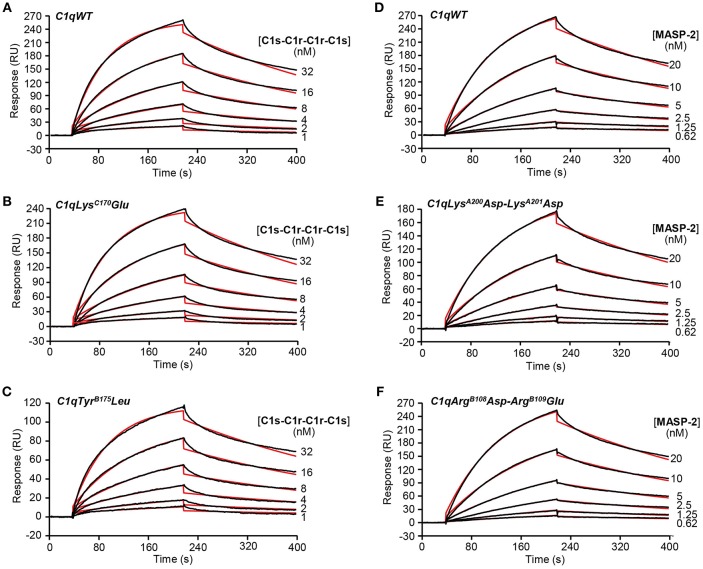
Kinetic analyses of the interaction of the C1s-C1r-C1r-C1s tetramer and the MASP-2 dimer with immobilized C1q variants. Sixty microliter of the C1s-C1r-C1r-C1s tetramer at the indicated concentrations were injected over (A) C1qWT (16,300 RU), (B) C1qLysC170Glu (17,000 RU) and (C) C1qTyrB175Leu (12,200 RU) in 50 mM Tris-HCl, 150 mM NaCl, 2 mM CaCl2, 0.005% surfactant P20, pH 7.4 at a flow rate of 20 μl/min. The MASP-2 dimer was injected over (D) C1qWT (13,600 RU), (E) C1qLysA200Asp-LysA201Asp (13,000 RU), and (F) C1qArgB108Asp-ArgB109Glu (13,700 RU) under the same conditions as in (A–C). The binding signals shown were obtained by subtracting the signal over the BSA reference surface and further subtraction of buffer blanks. Fits are shown as red lines and were obtained by global fitting of the data using a 1:1 Langmuir binding model. Chi2 values were between 0.9 and 5.9. Each kinetic analysis shown is representative of two independent experiments performed on separate sensor chips.